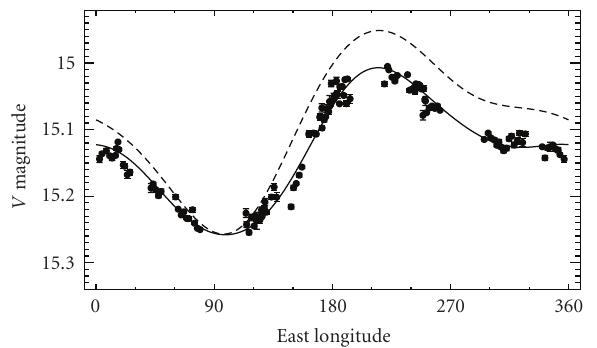
Figure 4: Lightcurve of Pluto in March-July 2000. The rotation period of Pluto is roughly 6.4 days and requires many nights to obtain a complete lightcurve. The points with error bars are the result of 35 nights of observation and nearly 1000 individual images. The solid curve is a 4-term fourier series fit to the lightcurve. For comparison the lightcurve from 1986 is shown (dashed line). Figure 5: Lightcurve of W Corvi in 1999 and 2001 with the 0.8-m telescope. The 1999 data (diamonds) were taken with a classically operated CCD system in V . The 2001 data (+) were taken with the PCCD camera and the robotic system in BVRI (only V data are shown). Figure used with permission from Odell